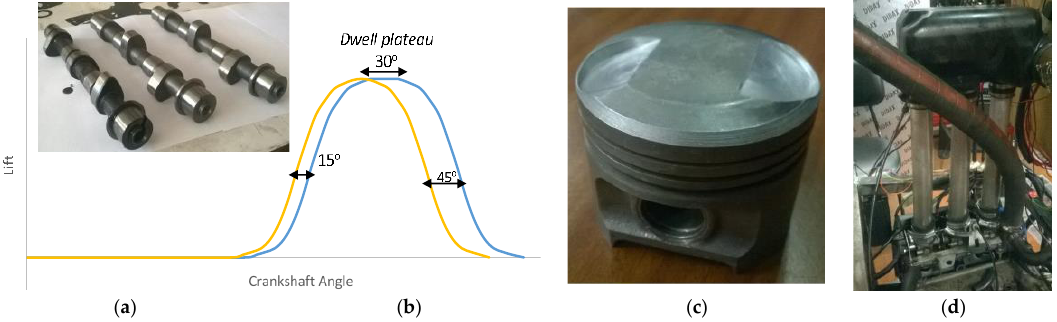
Figure 4. ( a ) Inlet camshafts tested (left to right): stock, dwell 45, dwell 50; ( b ) outline of the dwell 45 cam profile; ( c ) machined piston (with 45° edge) and ( d ) long inlet pipes installed at intake to avoid LIVC charge backflow.